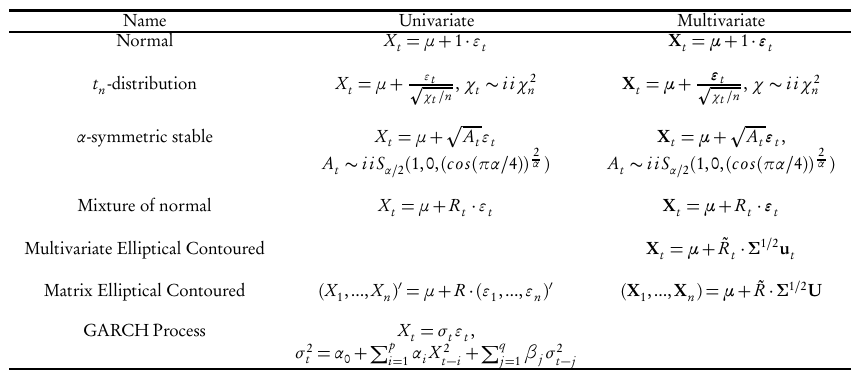
Univariate and multivariate models of financial data. In the table ǫ distributed with the mean 0 and the variance σ 2 . ǫ a k-dimensional random vector uniformly distributed on the unit sphere in IR k . U = ( v with vech ( U ) to be uniformly distributed on the unit sphere in IR nk . S univariate α -stable distribution with the skewness parameter γ , the mean µ and the variance σ 2